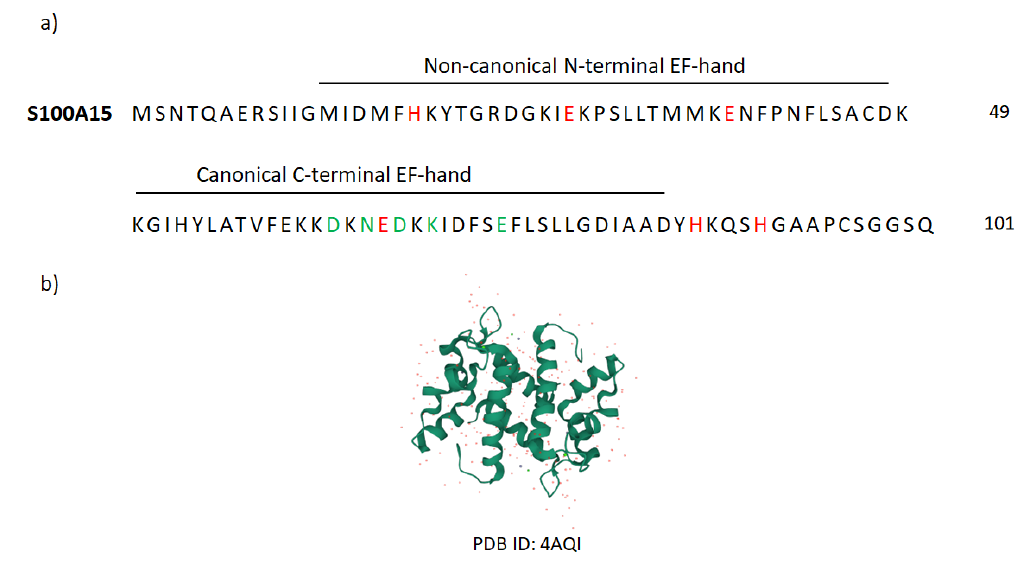
Figure 4. Structures of S100A15 protein: ( a ) predicted amino acid sequence of the human S100A15 (the red color marks those amino acids that bind Zn 2+ , while the green color marks the amino acids that bind Ca 2+ ); ( b ) structure of human S100A15 coordinating Zn 2+ and Ca 2+ —image from the RCSB PDB (rcsb.org) of PDB ID 4AQI